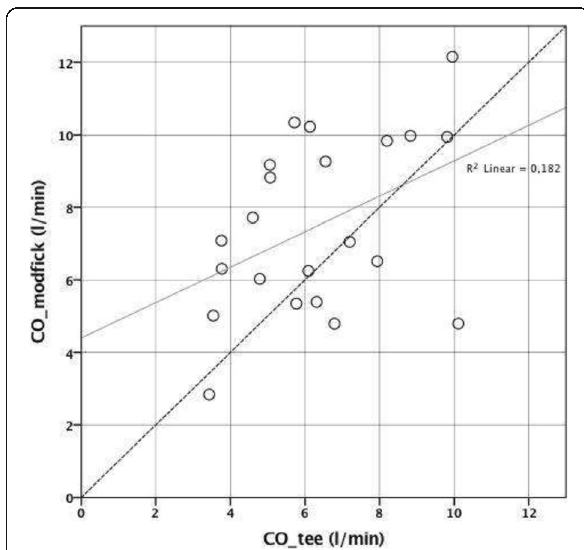
Fig. 1 (abstract 0337). Cardiac Output: TEE vs. modified Fick's principle on ECMO